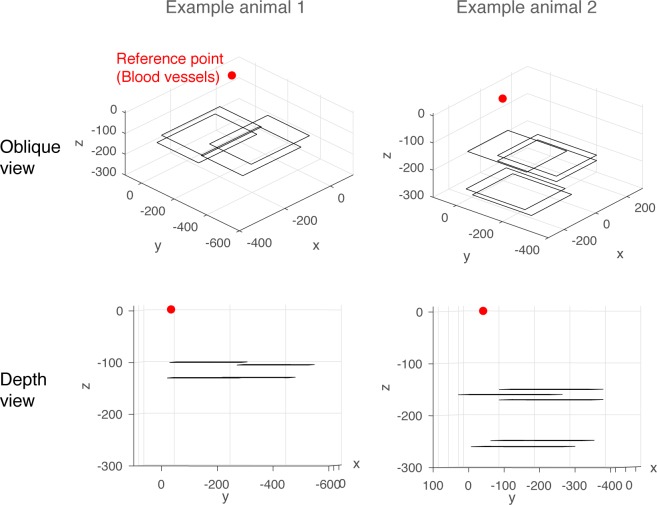
Examples of imaged planes.For each imaging session, images were obtained from a 256 μm x 256 μm field of view from a single plane. In each animal, imaging sessions took place over multiple sessions, depending on the quality of the optical window, as well as the presence of odour-responsive neurons. The panels show all imaged planes from two example mice, with two viewing angles.